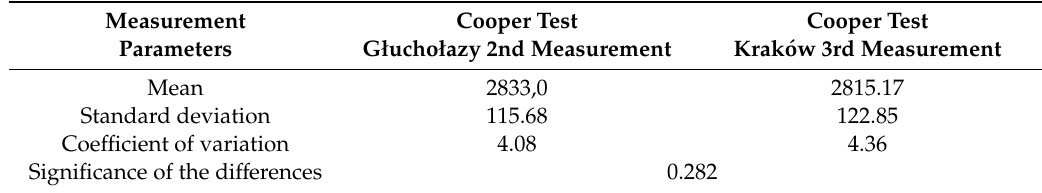
Table 7. The values of the stamina and performance parameters of the football players in the 2nd measurement in Głuchołazy and the 3rd measurement in Krak ó